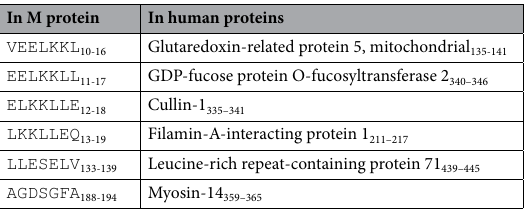
Table 4. Localization of homologous 7-mers in the M protein and human